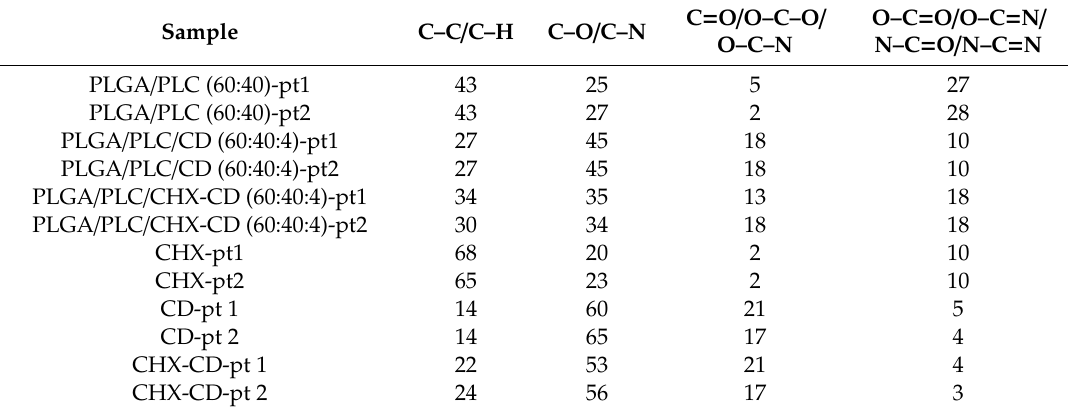
Table 3. Elemental C1s photopeak synthesis measured by XPS on the PLGA / PLC (60:40) membrane, PLGA / PLC (60:40) membrane with CD (4%), PLGA / PLC (60:40) membrane with CHX-CD (4%) and CHX, CHX, CHX-CD